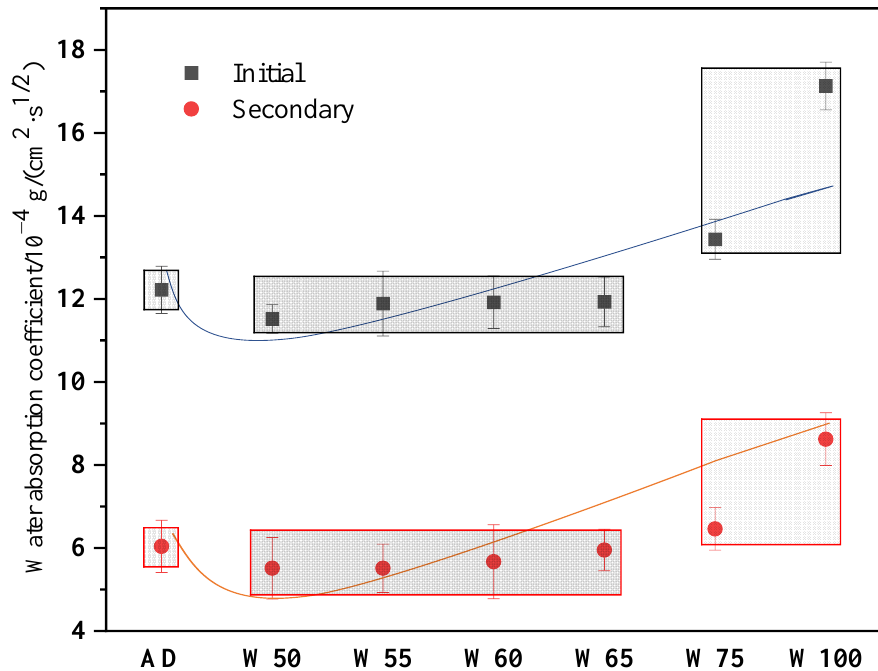
Figure 11. Water adsorption coefficient of recycled concrete.